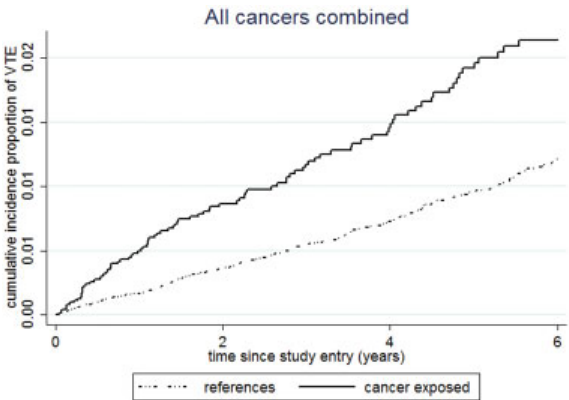
Fig.1 Cumulative incidence proportion of venous thromboembolism (VTE) incancer-exposedsubjectsand reference subjects. Deathaswell as fi rst and second cancer, respectively, is treated as competing risks in reference subjects and cancer